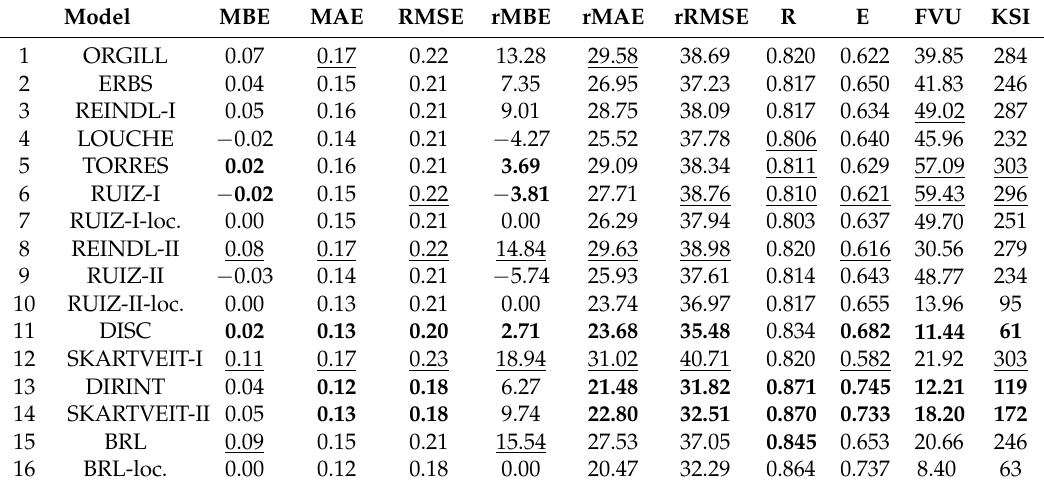
Table 3. Performance statistics for the different decomposition models applied to the Bolzano station data, evaluated over hourly diffuse horizontal irradiation (DHI) values: mean bias error (MBE), mean absolute error (MAE), and root mean square error (RMSE) are in MJ m − 2 , while relative